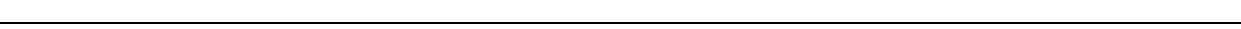
Fig. 1 HSF1, PARP13, and PARP1 form a ternary complex. a HEK293 cells were transfected with HA-tagged PARP proteins, and subjected to HSF1 immunoprecipitation and immunoblotting. Asterisks indicate the full-length products from the transfected PARP constructs. b hPARP13-His puri fi ed from bacteria was pulled down with puri fi ed GST, GST-hPARP1, GST-hHSF1, GST-hHSF2, or GST-hHSF4, and subjected to immunoblotting. Input of PARP13-His was also shown at the bottom. Asterisks indicate full-length GST-fusion proteins. c Endogenous immunoprecipitation in nuclear fractions of HeLa cells, in which PARP1 or PARP13 was knocked down by infection with adenovirus expressing the corresponding shRNA, or scrambled RNA (SCR) as control. Input: PARP1, 1%; PARP13, 5%; HSF1, 1%. Immunoprecipitate (IP), 100%. Percentages of co-precipitated PARPs are shown. Nuclear (N) and cytoplasmic (C) fractions were blotted using an antibody for nuclear (SP1) or cytoplasmic (HSP90) protein. d The DNA-binding domain of HSF1 interacts with PARP13. GST-pull-down from mixtures of puri fi ed hPARP13-His and GST-fused hHSF1 mutants was performed, and proteins were subjected to immunoblotting. DBD DNA-binding domain; HR hydrophobic heptad repeat; DHR downstream of HR-C. e Alignment of the amino-acid sequences of the DNA-binding domains in hHSF1, hHSF2, and hHSF4. Thirteen residues in HSF1 differing among three sequences were substituted with alanine (black dots) or